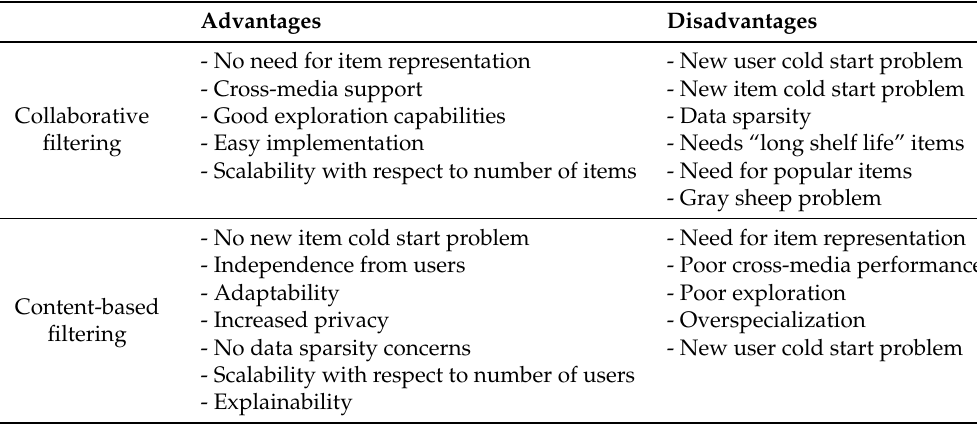
Table 1. A summary of the advantages and disadvantages of collaborative filtering and content-based filtering